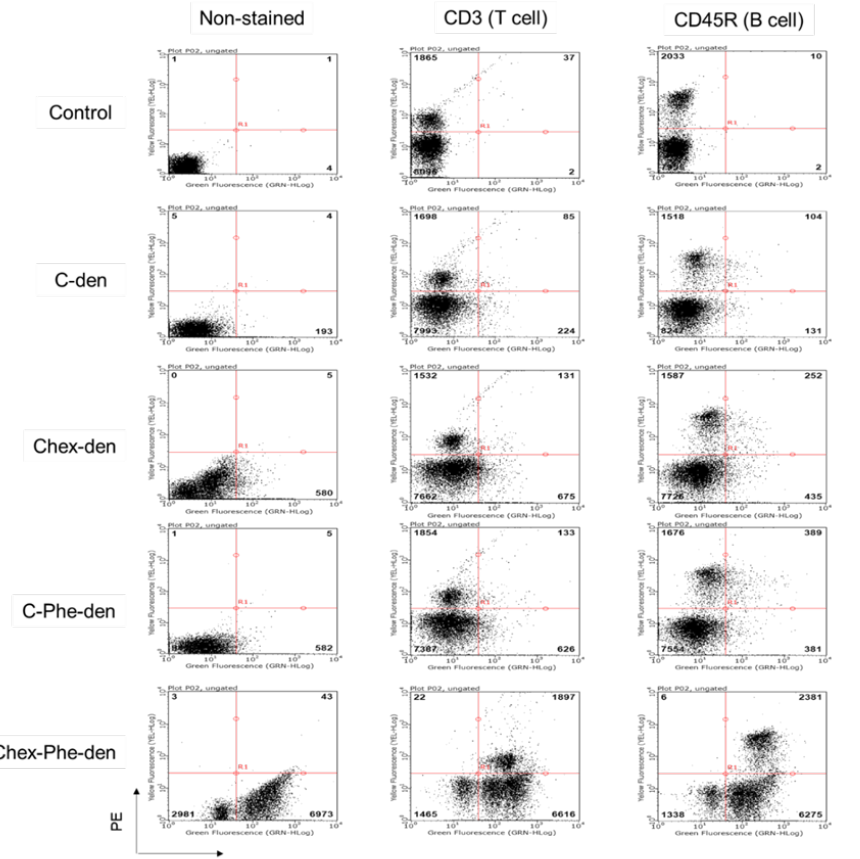
Figure 2. Flow cytometry of non-stained and Phycoerythrin (PE)-stained immune cells, treated with the green fluorescent dye-conjugated dendrimers at 37 °C.